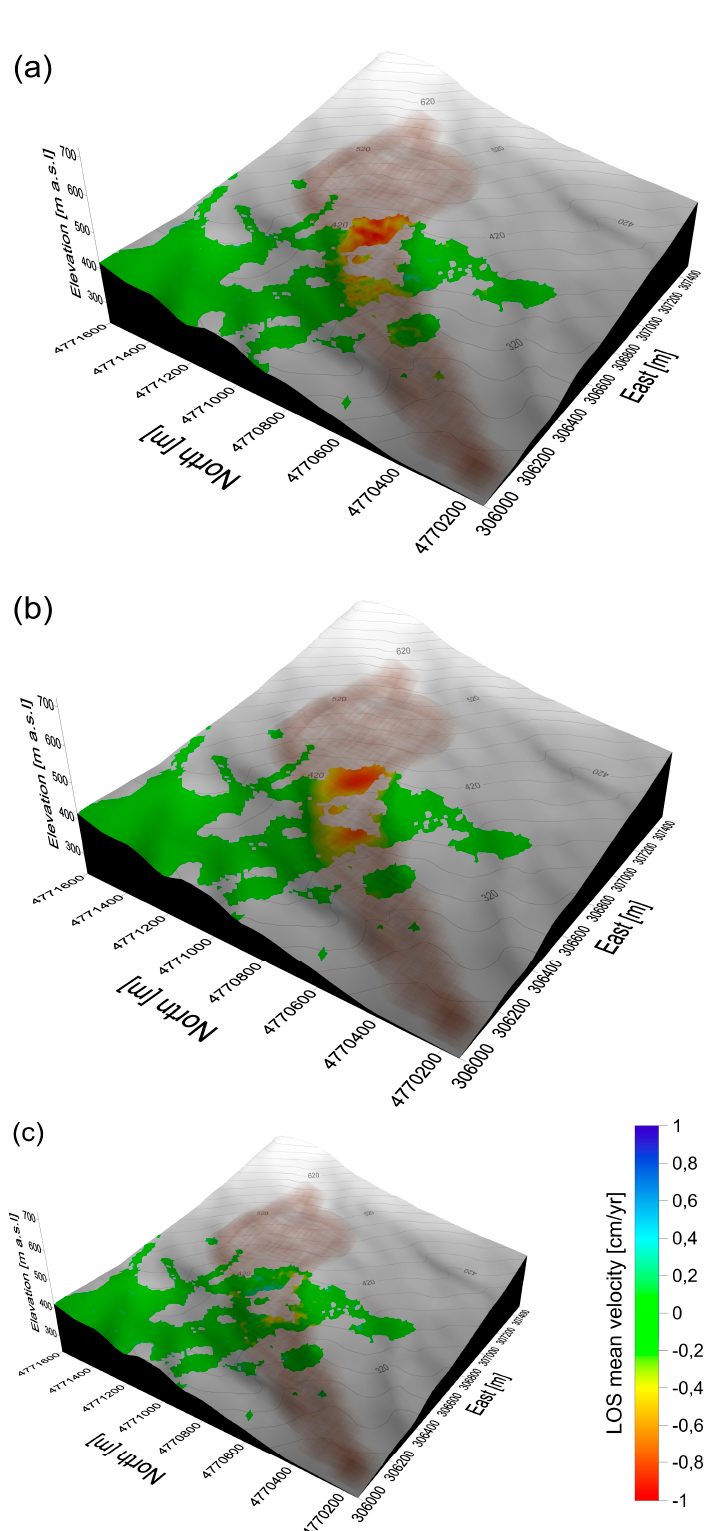
Figure 5. Geodetic inversion results: ( a ) Data; ( b ) Model and ( c ) Residuals relevant to the DInSAR velocity map superimposed on the filled contour DEM. The shading area indicates the unstable slope mass.